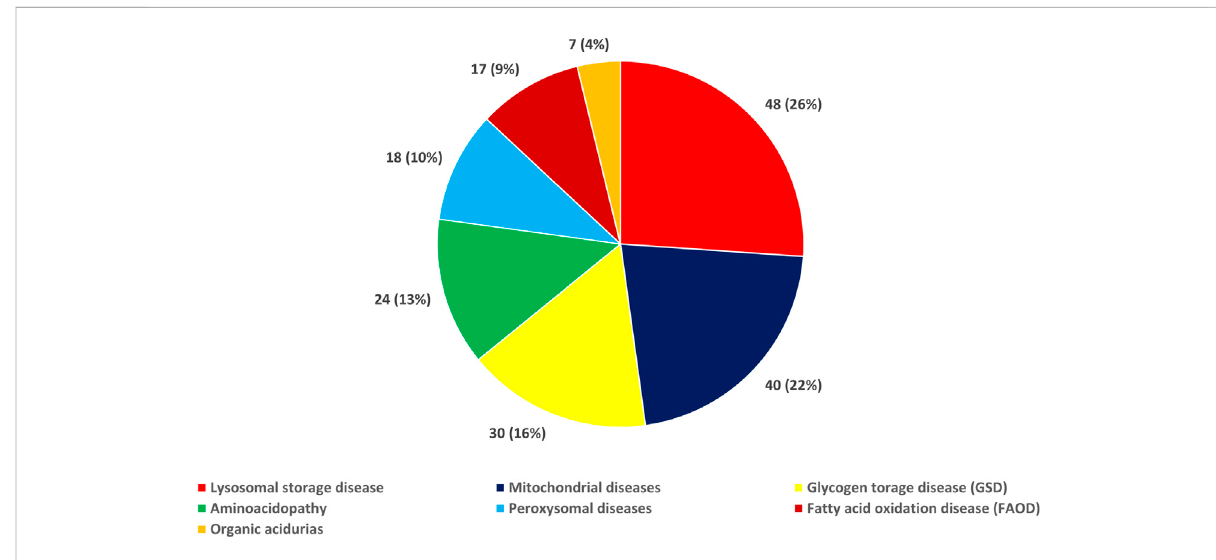
FIGURE 1 Distribution of the types of inborn errors of metabolism in the study